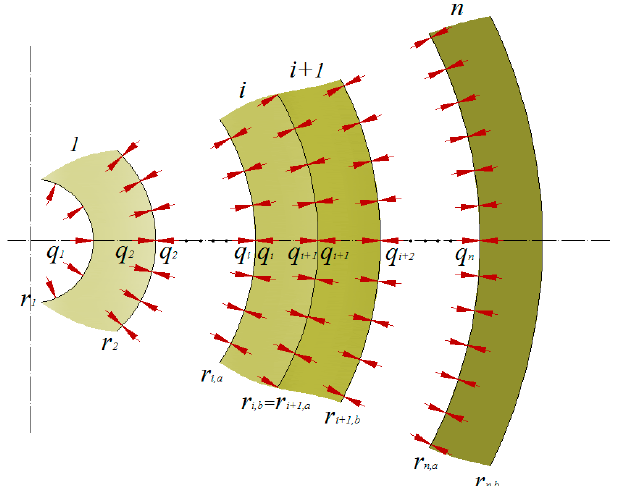
Figure 4. Model of a multi-layer pipe loaded with interlayer pressure assumed for the calculations, where r—radius, i—layer, q—inter-layer pressure.